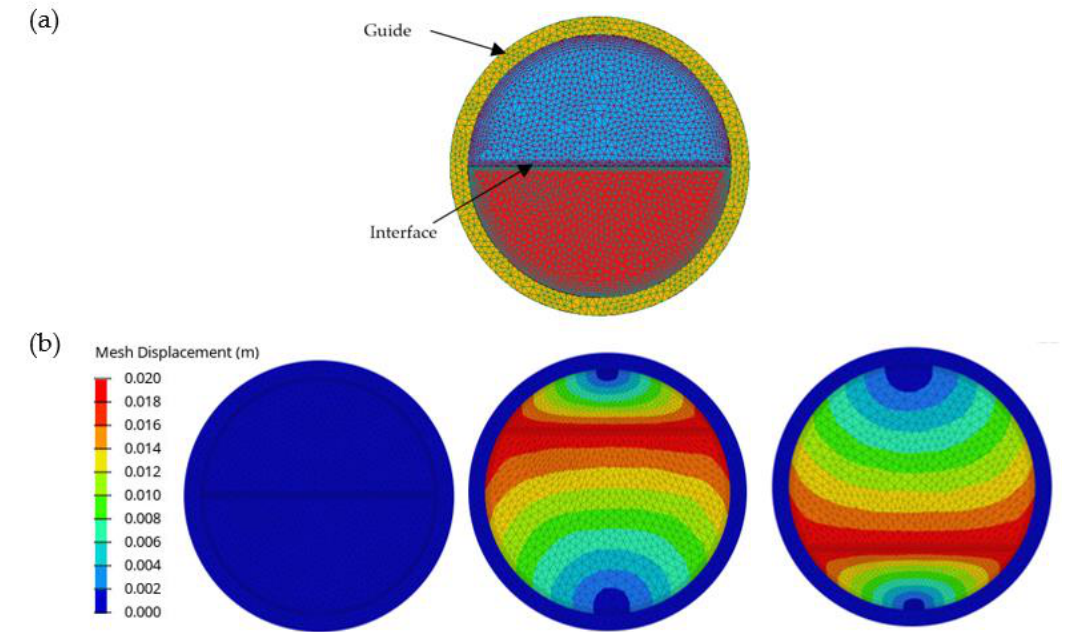
Figure 4. ( a ) Design of inlet to enable the prescription of perturbation and ( b ) Mesh motion due to the inlet perturbation.